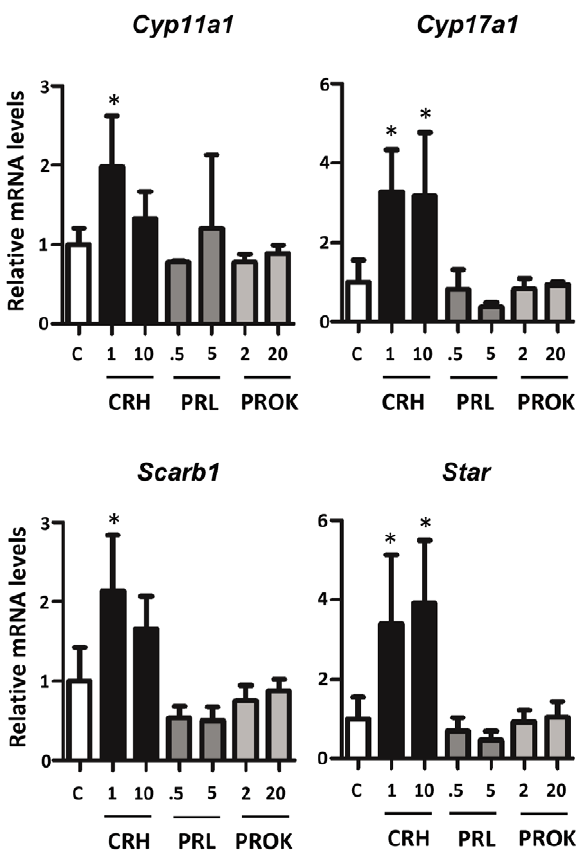
Figure 3. GD17 rat testis steroidogenic gene expression after treatment with CRH, PRL, or PROK2. Testes were exposed for 24 hours in vitro to varying concentrations of CRH, PRL, or PROK2. Taqman-based qRT-PCR was used for determination of mRNA levels. Three to four samples per group. Mean 6 SD are shown for all data. C: control. Asterisk indicates significance for p-value of , 0.05 when compared with controls.